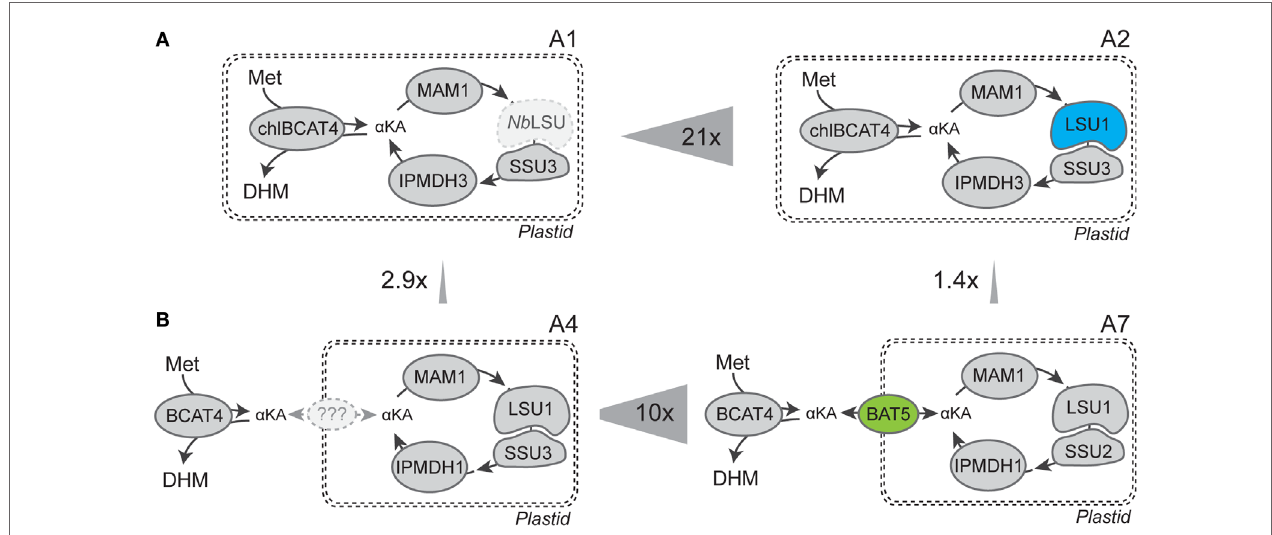
FigUre 3 | graphical comparison of combinations with most significant increases in DhM production . (a) Nicotiana benthamiana LSU ( Nb LSU) can complement Arabidopsis IPMI small subunit (SSU3) into a functional heterodimer, and co-expression of Arabidopsis IPMI large subunit (LSU1) increased DHM production by 21-fold. (B) BAT5 is an efficient transporter for translocation of intermediates between the cytosolic BCAT4 and the chloroplast-localized part of methionine chain elongation and increased DHM production by